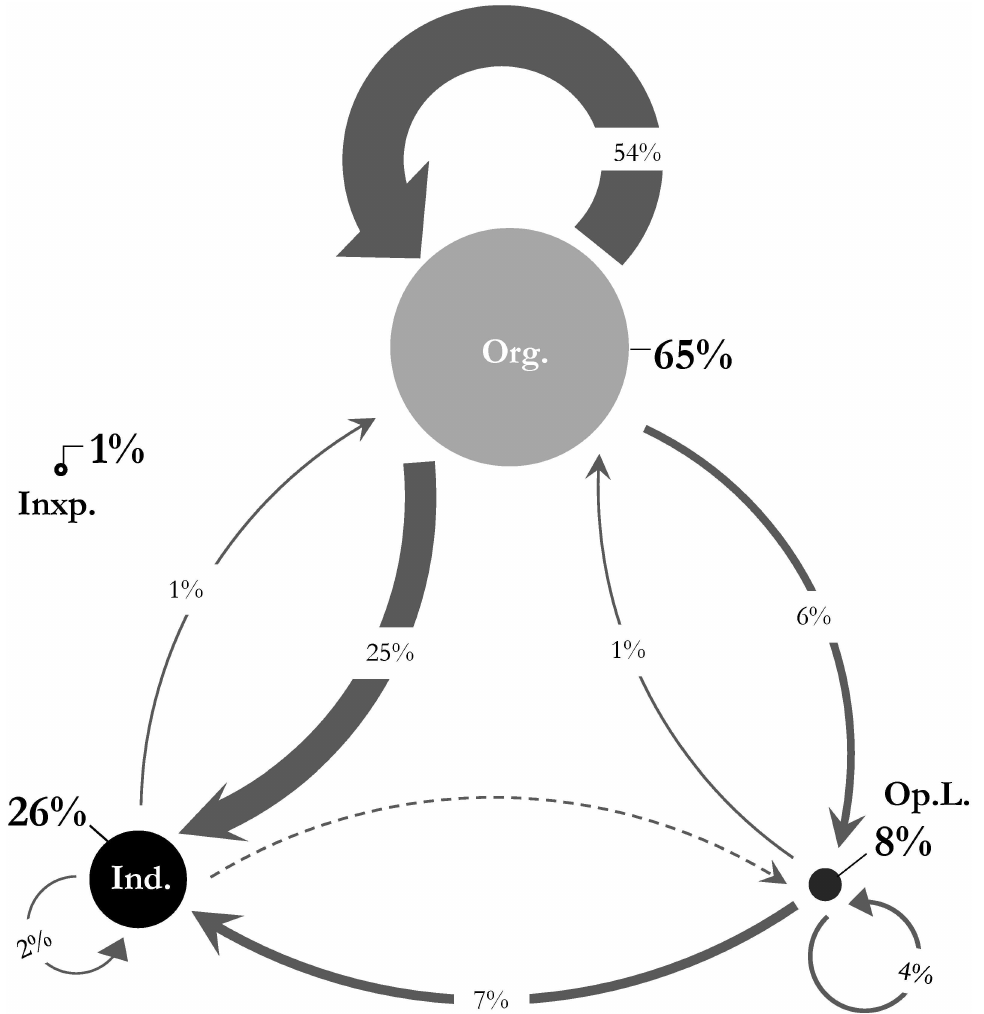
Fig 4. Diffusion Flow. Diffusion flow between three entities of: (1) Organizations (Org.), (2) Opinion Leaders (Op.L.), and (3) Individuals (Ind.). The direction of arrows represent the retweeting behaviorand the thickness is indicative of the magnitudeof